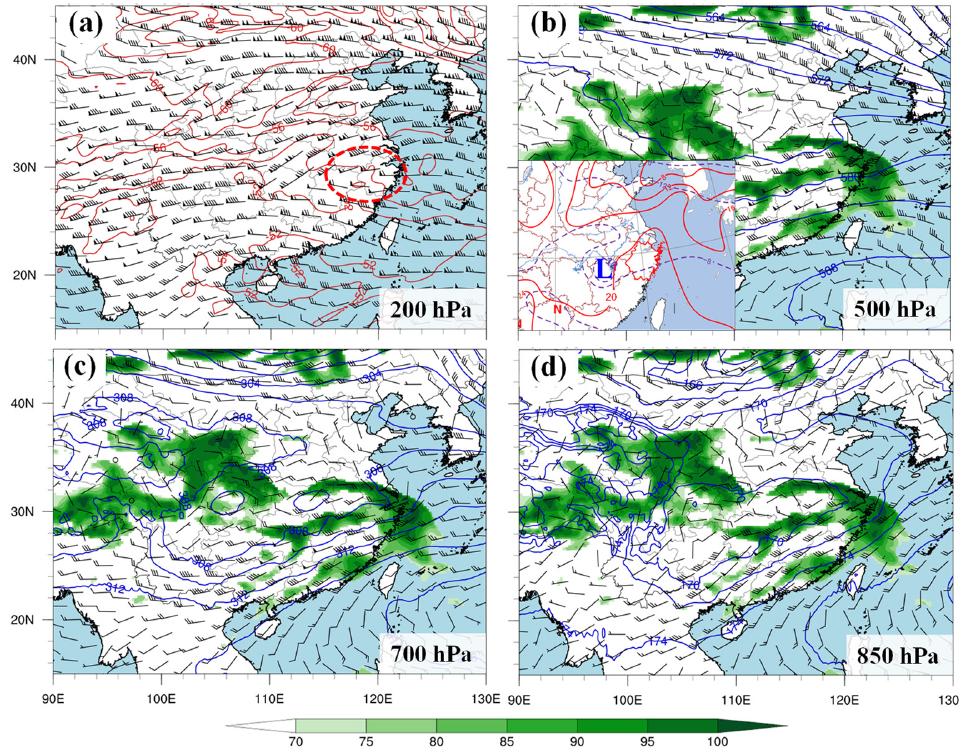
Figure 2. Synoptic maps from ERA5 data for 2000 BT on 10 May 2021. ( a ) The 200 hPa synoptic map. ( b ) The 500 hPa synoptic map. ( c ) The 700 hPa synoptic map. ( d ) The 850 hPa synoptic map. The solid blue lines are isopotential lines. The solid red lines are isotherms. The green shades indicate the relative humidity. The barbs indicate wind velocity and direction. The dashed purple lines and solid red lines in the plotted upper-level weather map in the lower left corner of ( b ) represent the 500 and 850 hPa isotherms, respectively.